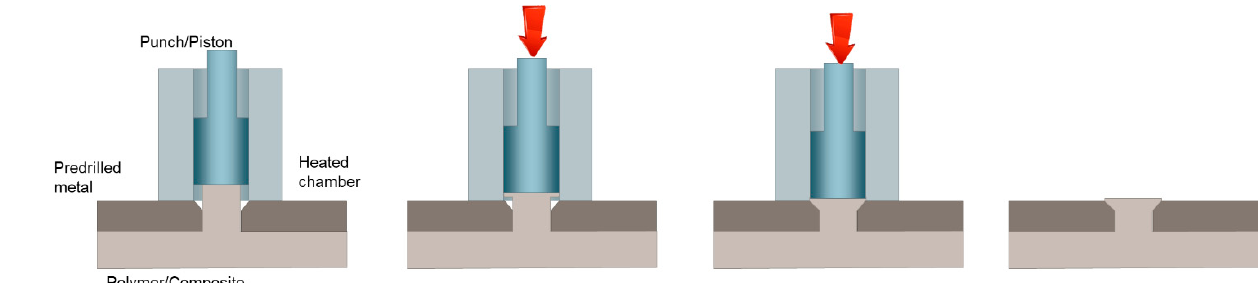
Figure 11. Schematic of the injection clinching joining process.